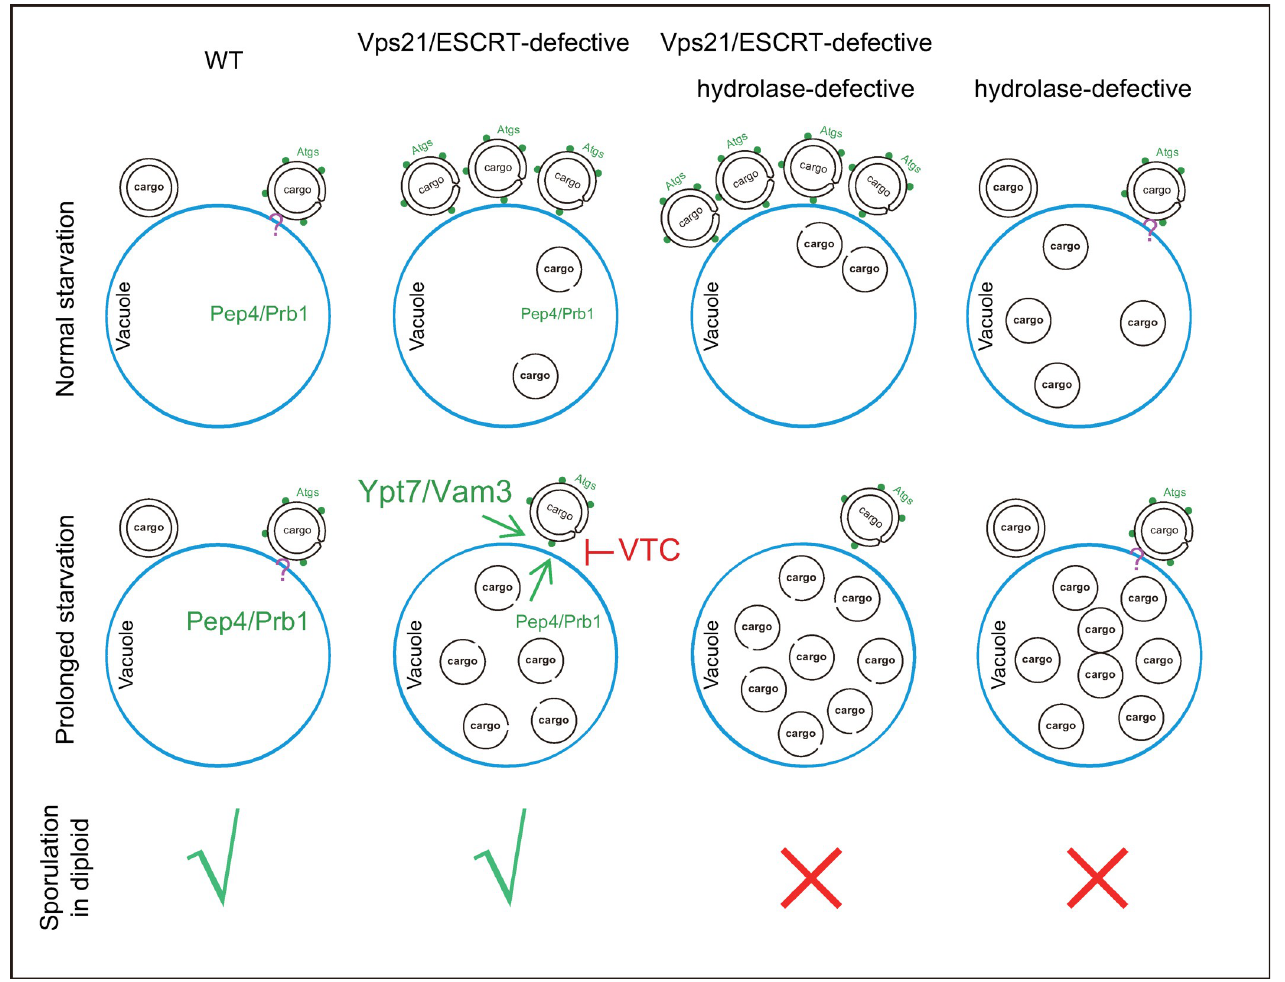
Fig 10. Diagram of the promotion of unclosed autophagosome entry into vacuoles in Vps21/Rab5- and ESCRT-mutant cells after prolonged nitrogen starvation. The entry of unclosed double-membrane autophagosomes into vacuoles after prolonged nitrogen starvation required Vam3 and Ypt7, was negatively promoted by VTC proteins, and was associated with the vacuolar hydrolases Pep4 and Prb1. However, it remains unclear how the unclosed double- membrane autophagosomes entered vacuoles to become unclosed single-membrane structures (autophagic bodies), which are sensitive to protease digestion, and are dissociated with Atg11. It also remains unknown whether unclosed autophagosomes in WT and hydrolase-defective mutants enter vacuoles. However, the entry of unclosed autophagosomes into vacuoles in diploid Vps21-mutant cells was clearly beneficial for